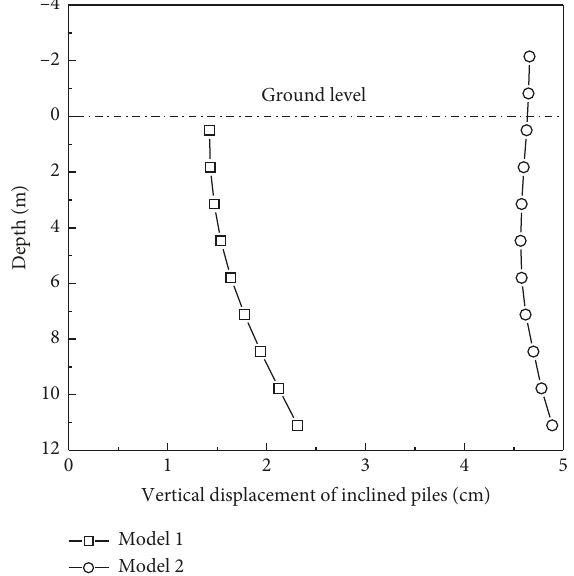
Figure 23: Contrastive analysis of vertical displacement of inclined piles.